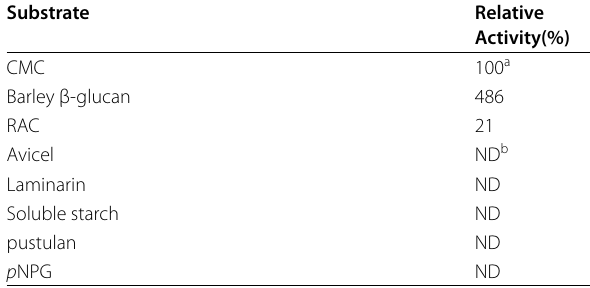
Table 2 Enzyme specificity for BcelFp on various substrates